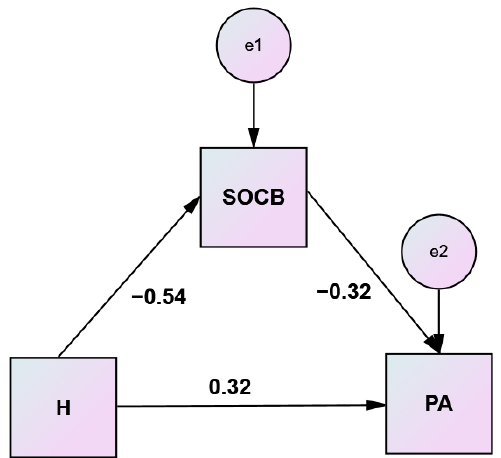
Figure 3. Simple mediation analysis of comprehensibility (SOC B) on hostility (H)–physical aggression (PA) relationship.